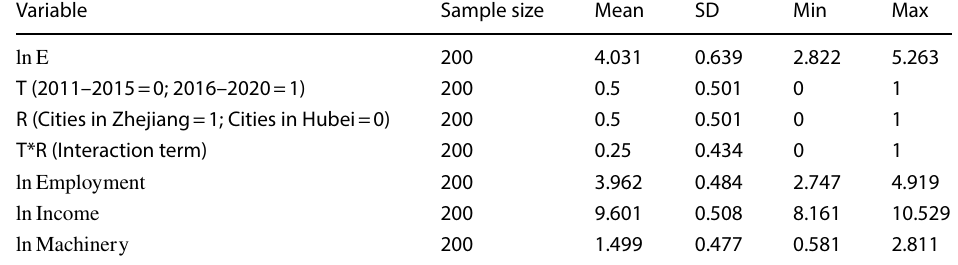
Table 10 Descriptive statistics of the variables in Eq.